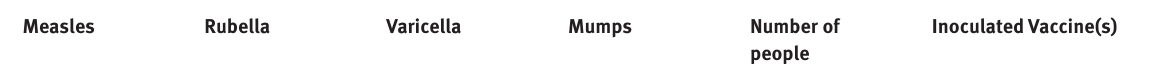
Table 2: Characteristics of 48 HCWs without sufficient antibody titer and administered vaccines.